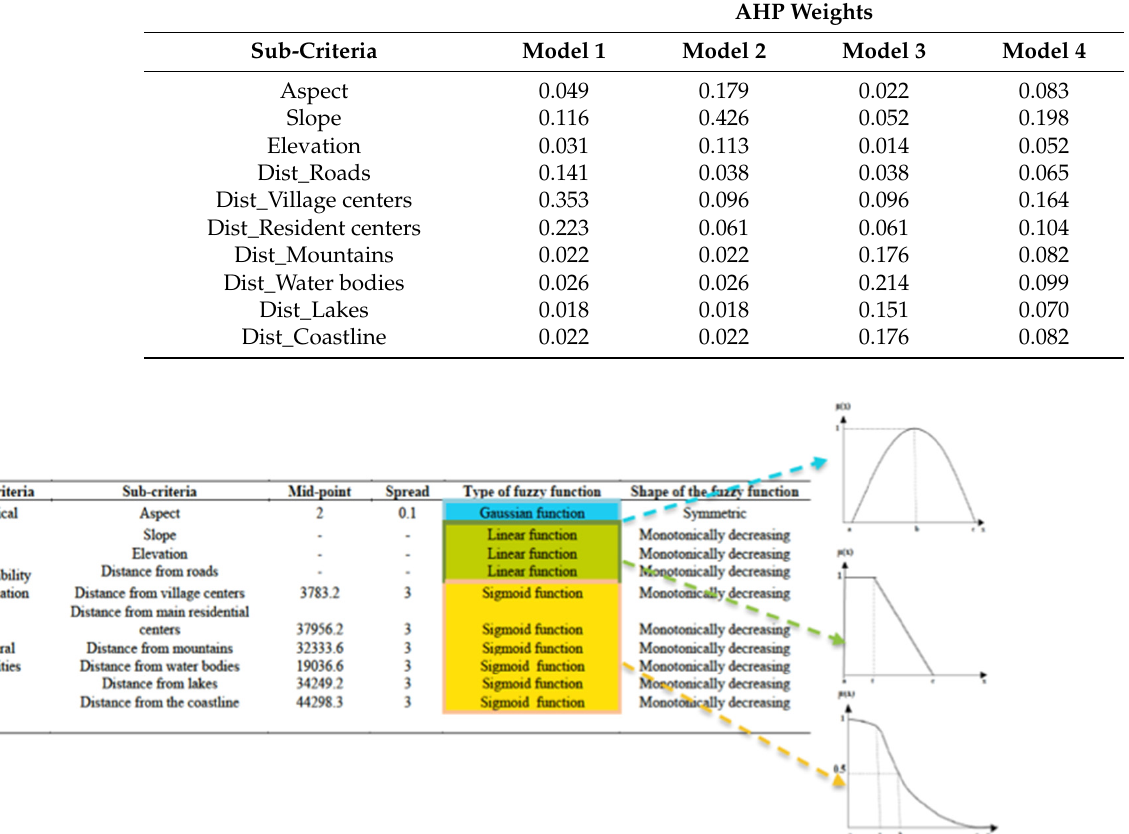
Figure 6. Selected factors for residential land suitability analysis.